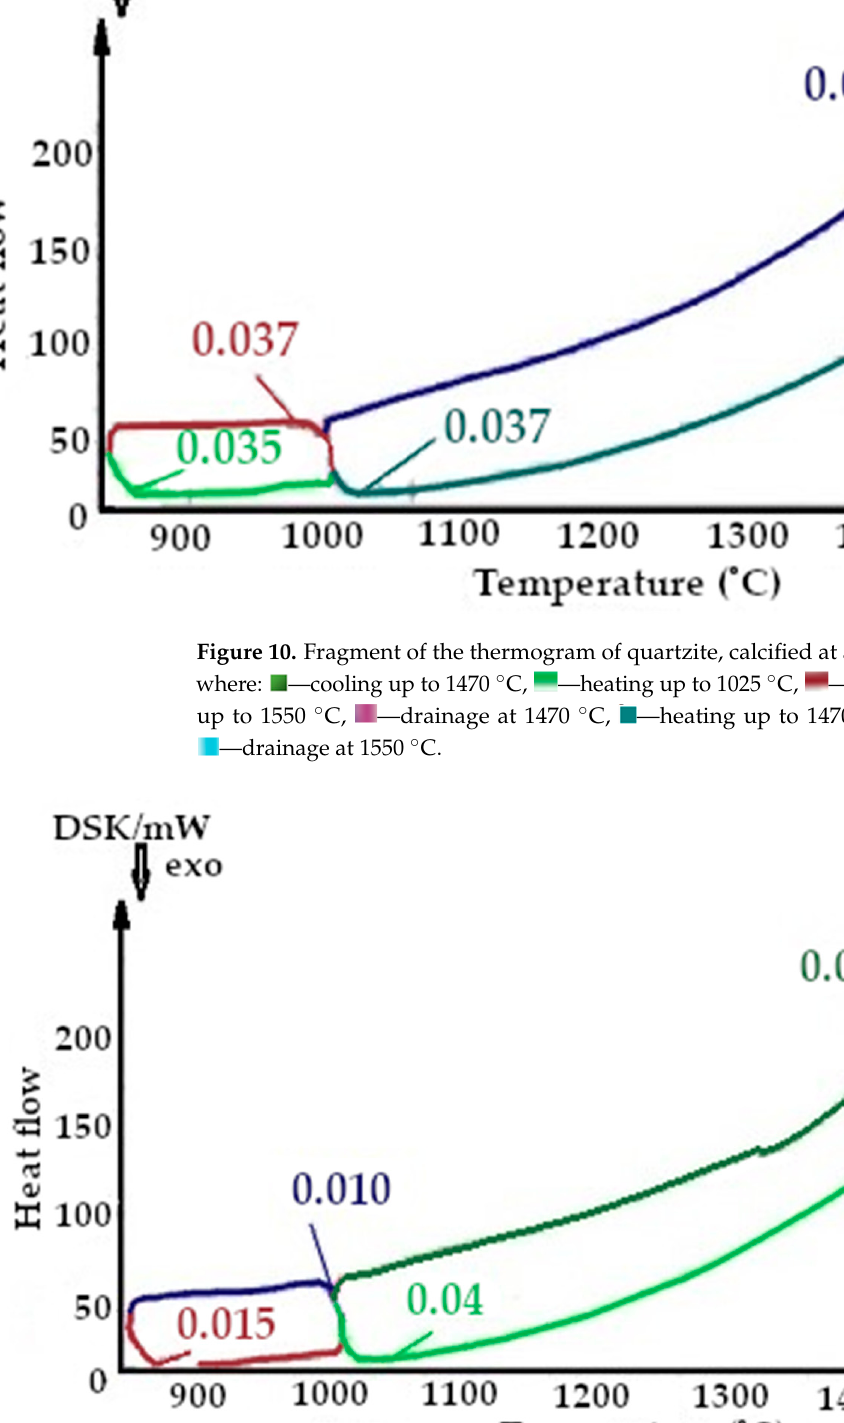
Figure 9. Fragment of the thermogram of quartzite, calcified at 800 °C (Cycle 1), where: